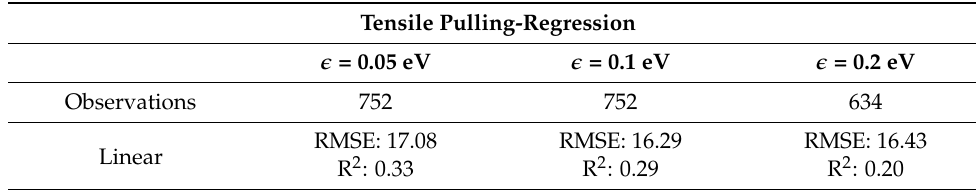
Table 1. Prediction performance of the SVM with various kernels on rough surfaces with different epsilon values. The RMSE values have units of MPa. The smaller RMSE, the higher the prediction accuracy. The R 2 values are dimensionless. The higher the R 2 , the better the prediction. Tensile Pulling-Regression (cid:101) = 0.05 eV Observations 752